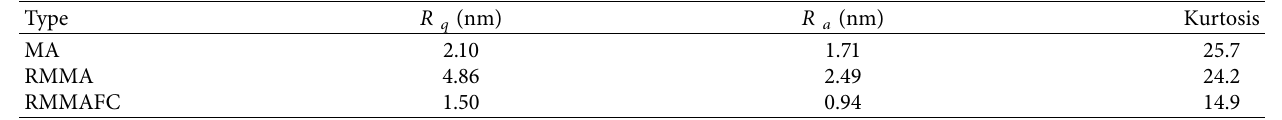
Table 3: Asphalt AFM image parameters analysis.